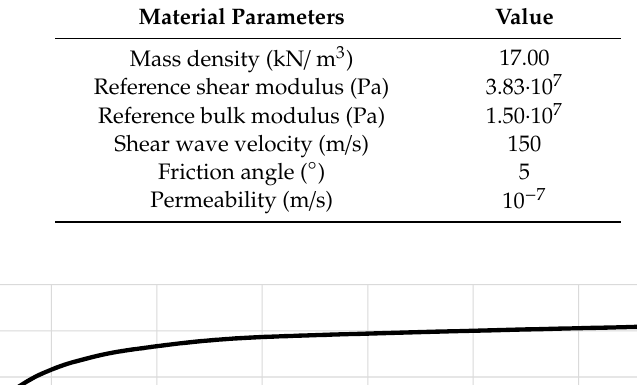
Table 6. Material parameters (foundation).